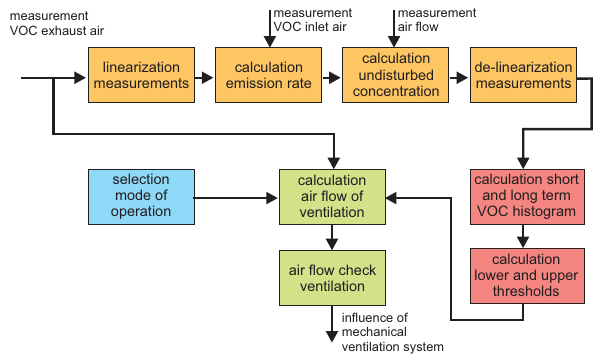
Figure 7. Schematic drawing of the air quality